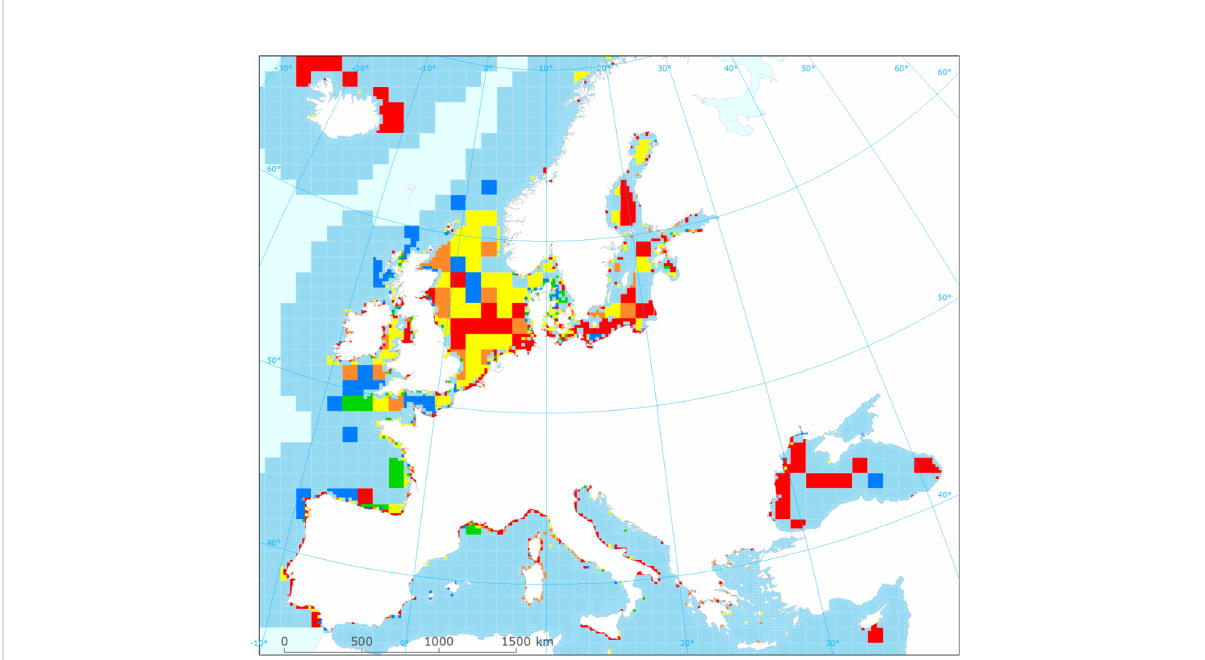
FIGURE 4 Mapping of contamination ‘ non-problem areas ’ (NPA) and ‘ problem areas ’ (PA) based on a European-wide application of CHASE. Maps of sub- regions can be found in the Supplementary Material. Please note the colour coding is the same as in Figures 2,